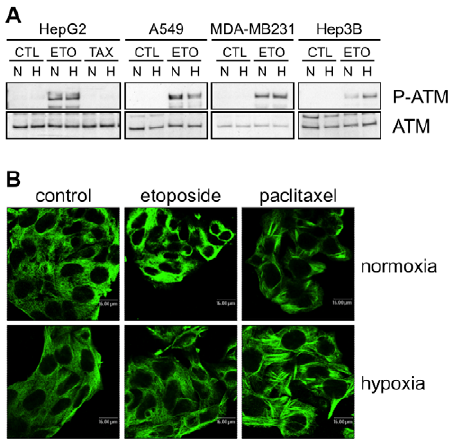
Figure 2. Effects of hypoxia on drug-induced damage. (A) Effect of hypoxia, etoposide and paclitaxel on the abundance and phosphor- ylation of ATM. HepG2, A549, MDA-MB231 and Hep3B cells were incubated 1 hour under normoxia (N, 21% O 2 ) or hypoxia (H, 1% O 2 ) in the presence or not (CTL) of etoposide (ETO, 100 m M in Hep3B cells and 50 m M in the other cell types) or paclitaxel (TAX, 10 m M) in HepG2 cells. ATM and P-ATM were detected in nuclear protein extracts by western blotting using specific antibodies. One experiment representative out of three. Uncropped western blots are presented in Figure S1. (B) Effect of hypoxia, etoposide and paclitaxel on microtubules. HepG2 cells were incubated 16 hours under normoxia (21% O 2 ) or hypoxia (1% O 2 ) in the presence or not of etoposide (50 m M) or paclitaxel (10 m M). After the incubation, cells were fixed, permeabilised and stained for alpha-tubulin using a specific antibody. Observation was performed using a confocal microscope with a constant photomultiplier.